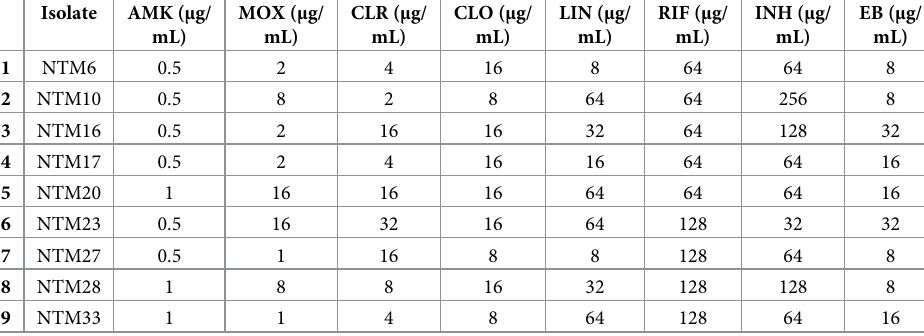
Table 5. Minimum inhibitory concentration of M . simiae